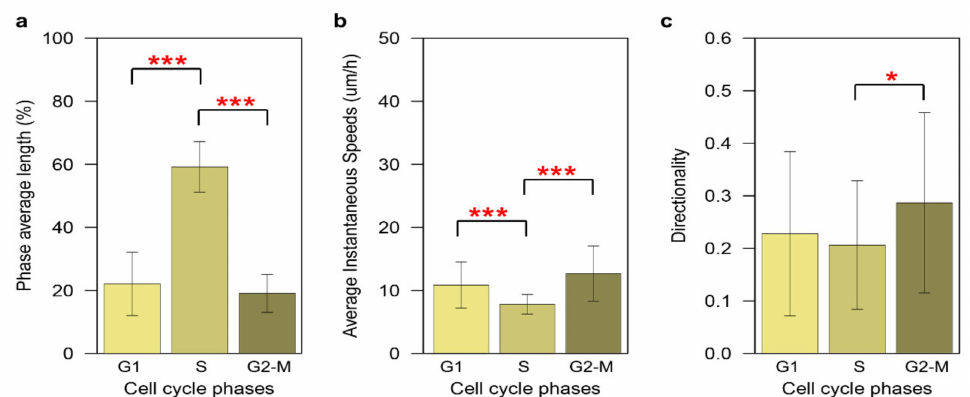
Figure 6. The speed–directionality dynamics across cell-cycle phases in RPE cells. ( a ) The duration distribution of each of the cell-cycle phases across all the dividing daughter cells ( n = 48). ( b ) Instantaneous speed dynamics across cell-cycle phases. ( c ) Directionality dynamics across cell-cycle phases. Statistical significance was determined using the Kruskal–Wallis rank sum test, followed by pairwise comparisons using the Wilcoxon rank sum test (* p < 0.05, *** p <